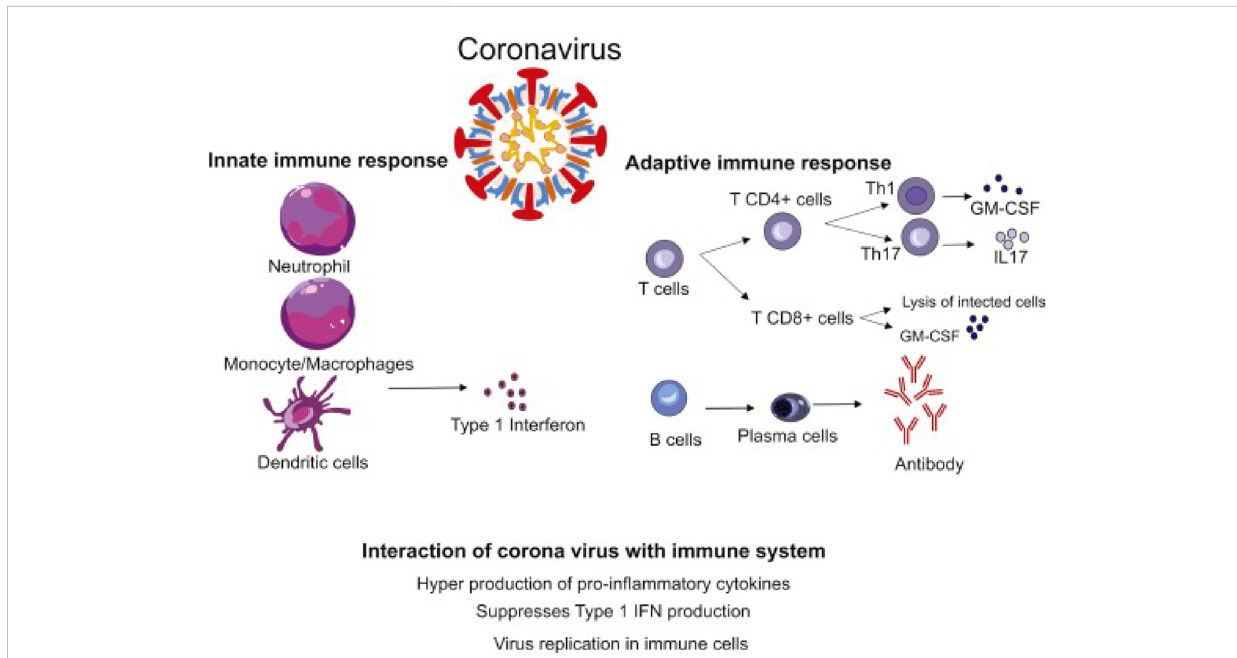
FIGURE 5 The immunological responses against COVID-9-coronavirus (CoV) disease, in both cases innate and adaptive immune responses. The secretion of numerous pro-in fl ammatory cytokines by neutrophils cells, monocytes cells, macrophages, and dendritic cells is referred to as a “ cytokine storm. ” Pulmonaryimmunopathologyistheresult ofthisprocess. Th1cellsandTh17 cellsandCD+Tcells maybestimulated,exacerbatinglung damage.Bylysis of tumor cells, the cytotoxic T-lymphocyte (CTL) contributes to antiviral therapy. Antibodies speci fi c to viruses are produced by B cells, and viruses are neutralized by them. (Adapted from Hosseini et al.,